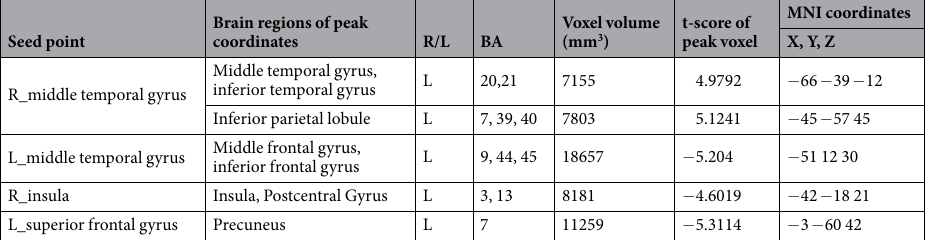
Table 4. Seed-based functional connectivity differences between PIs and GSs. Notes: Statistical threshold was set at voxel threshold of p < 0.01 and cluster threshold of p < 0.01with GRF correction. Abbreviations: PIs, patients with primary insomnia; GSs, good sleepers; R, right; L, left; BA, Brodmann’s area; MNI, montreal neurological institute; GRF, Gaussian random